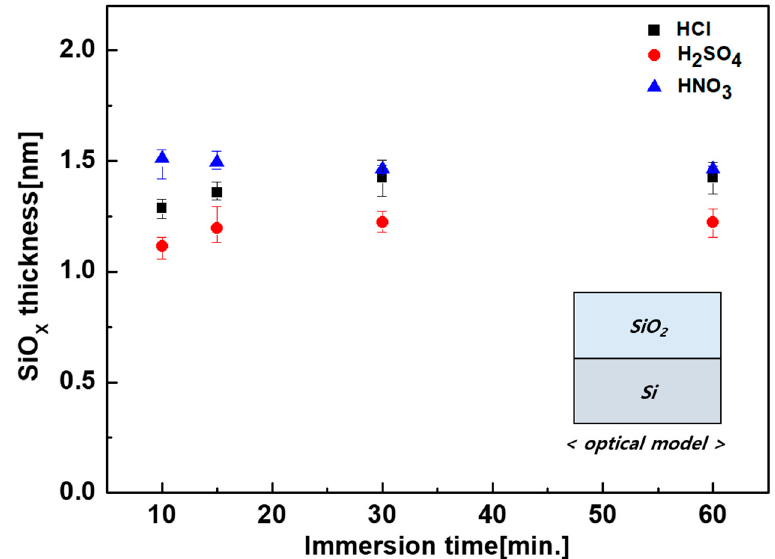
Figure 1. Measured thicknesses of wet chemical oxide (SiO x ) layers prepared in different acid solutions as a function of the immersion time. The optical model is shown in the insert (right bottom) for ellipsometry analysis. Table 1. SiO x layer thickness and refractive index (n) at an immersion time of 15 min. The data are averaged with ten samples.